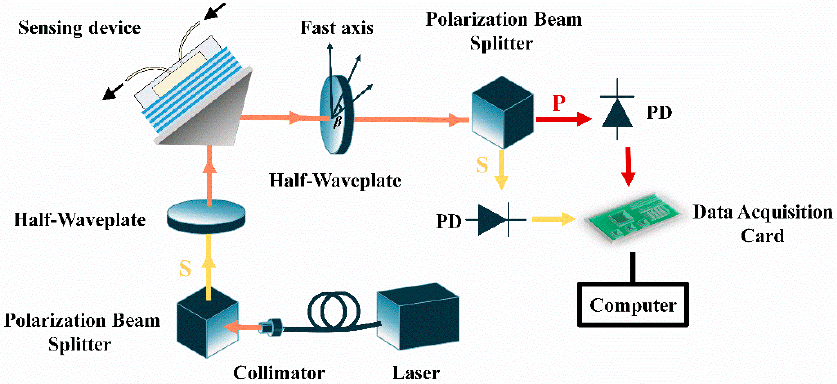
Figure 1. Schematic diagram of the proposed scheme.